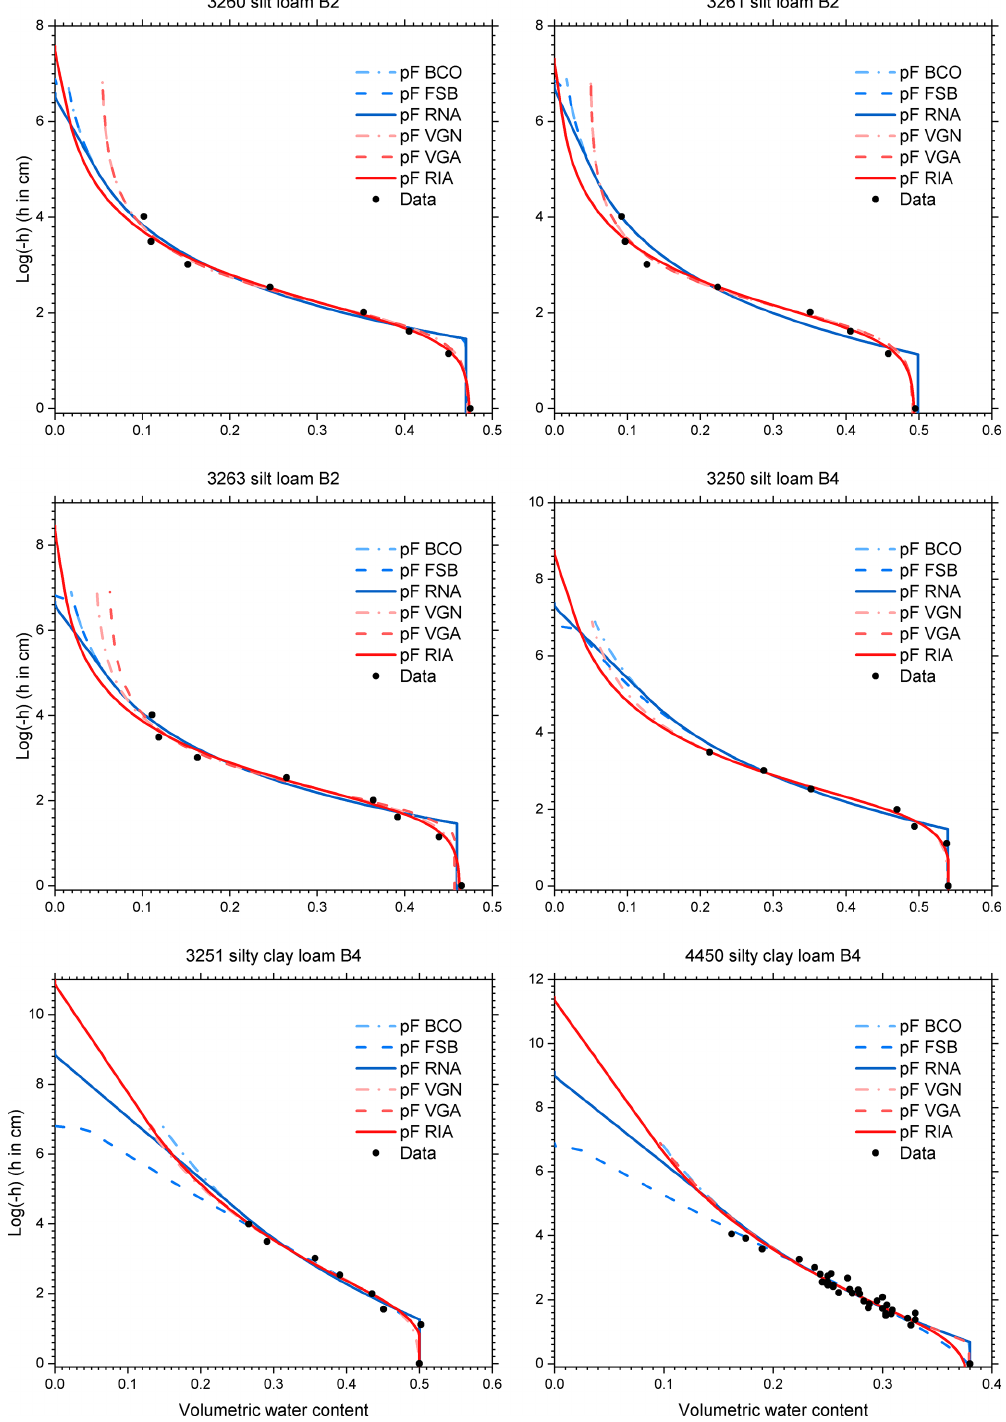
Figure C4. Retention data and fitted soil water retention curves according to six parameterizations for selected UNSODA soils with the B2 or B4 classification of Twarakavi et al. (2010). The parameterizations are explained in the